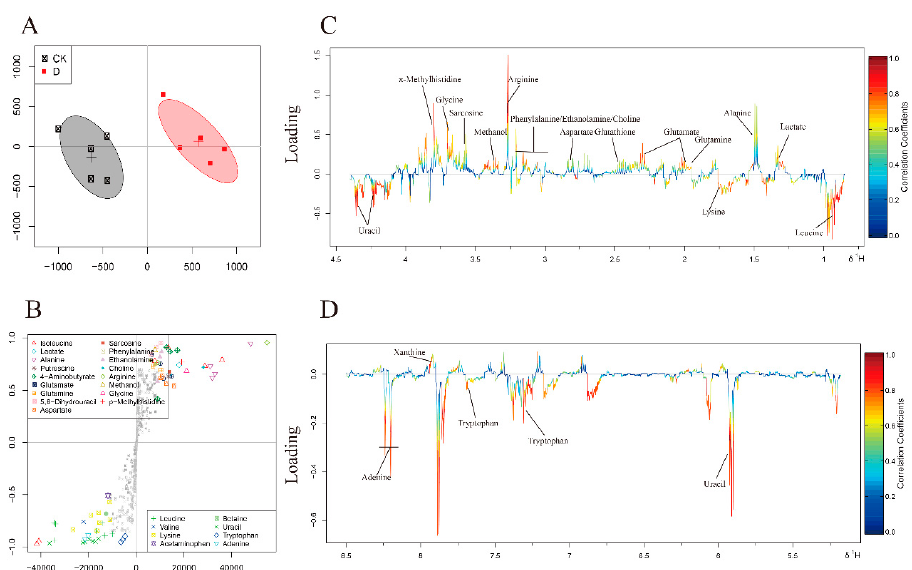
Figure 5. OSC-PLS-DA analysis of NMR data at 12 h. ( A ) The OSC-PLS-DA Score plot. ( B ) S-plot. ( C , D ) Color-coded loadings plots. The use of color bars, where red and blue represent metabolites, is statistically significant or insignificant in facilitating the separation of groups. In the CK group, the peak of the positive and negative states showed that the decrease and increase of metabolites were correlated with the score plot. The results of the normality test of metabolites are shown in Table 2. The folding changes (FC) of metabolites and their associated P values were calculated and corrected in color tables. Collapse change values are color-coded after log conversion. Cell units were filled with red or blue to indicate the increase or decrease respectively of metabolites in the carvacrol-treated group compared with the control group. Table 2. Differential expression of metabolites between two groups at 12 h. No